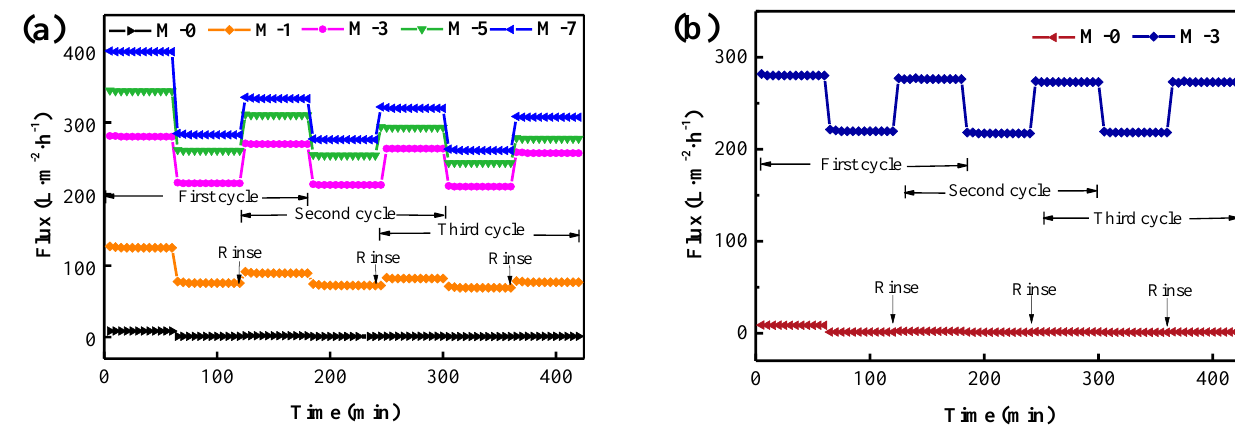
Figure 7. The three − cycle filtration experiments of PVDF and M-3 membranes contaminated by BSA solution ( a ) and contaminated by crude oil/water emulsion ( b ). Table 2. Antifouling properties of pristine blend membrane and modified membranes.